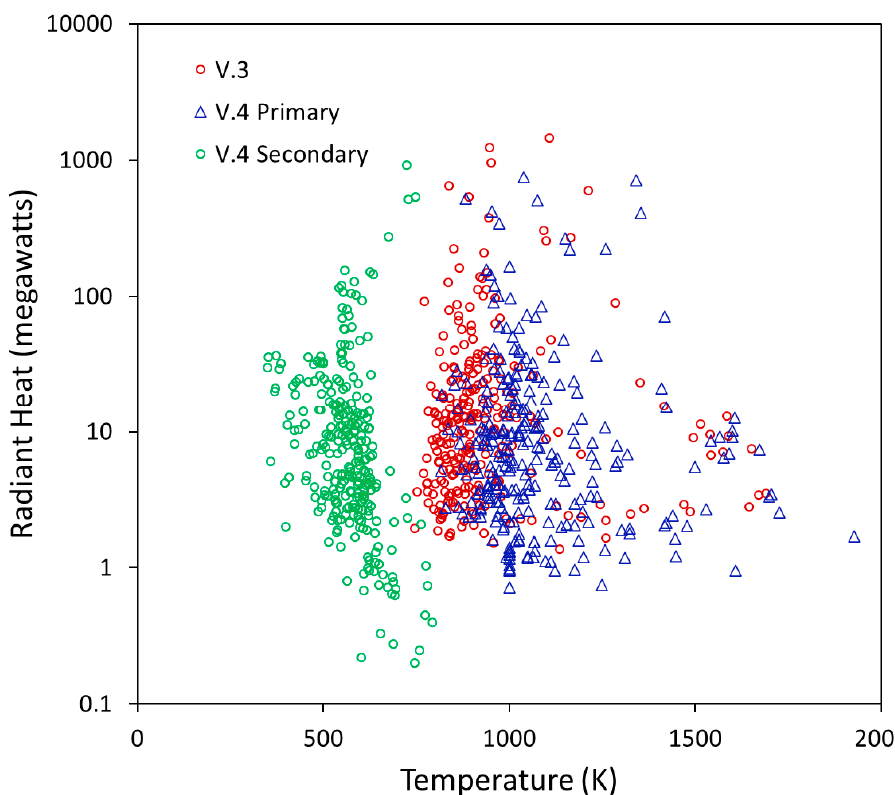
Figure 20. Temperature versus radiant heat for the Type 4 pixels having good fits from VNF V.3 and V.4 flaming subtrac- tive analysis.